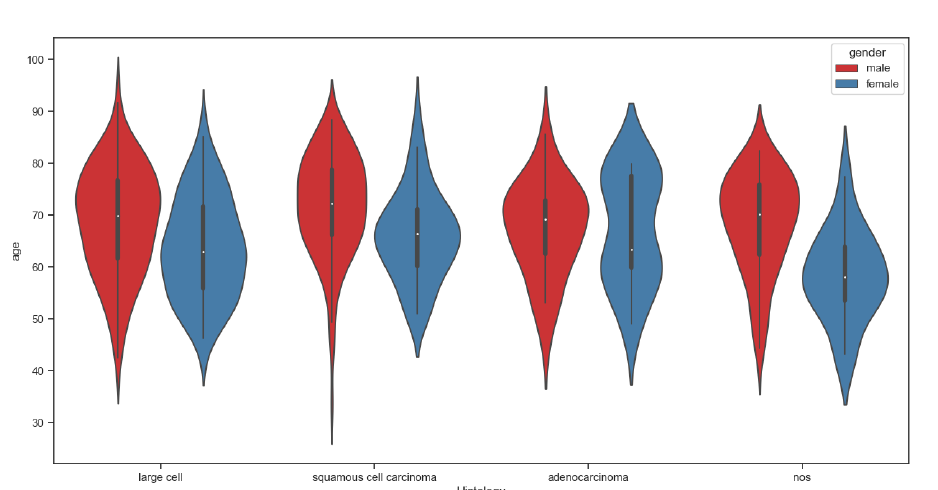
Figure 3. New Violin plot for the histology box-plot against age with distribution of genders (red: male and blue: